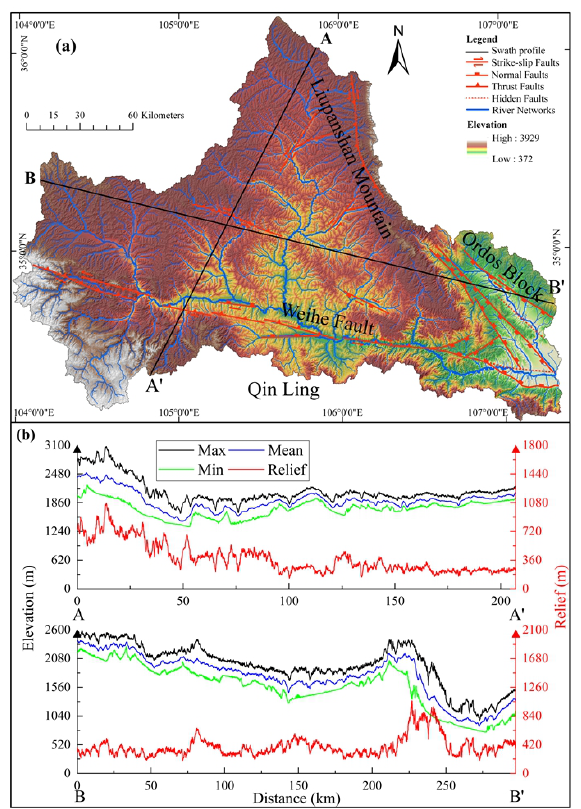
Figure 1. Topographic map of the upper reaches of the Weihe River, modified from (Li et al., 2012a; Chen Shi et al., 2018, Shi et al., 2018). The SRTM1 data is available at https://earthexplorer.usgs.gov. The relief is extracted by using the SWATH tool (Pérez-Peña et al.,